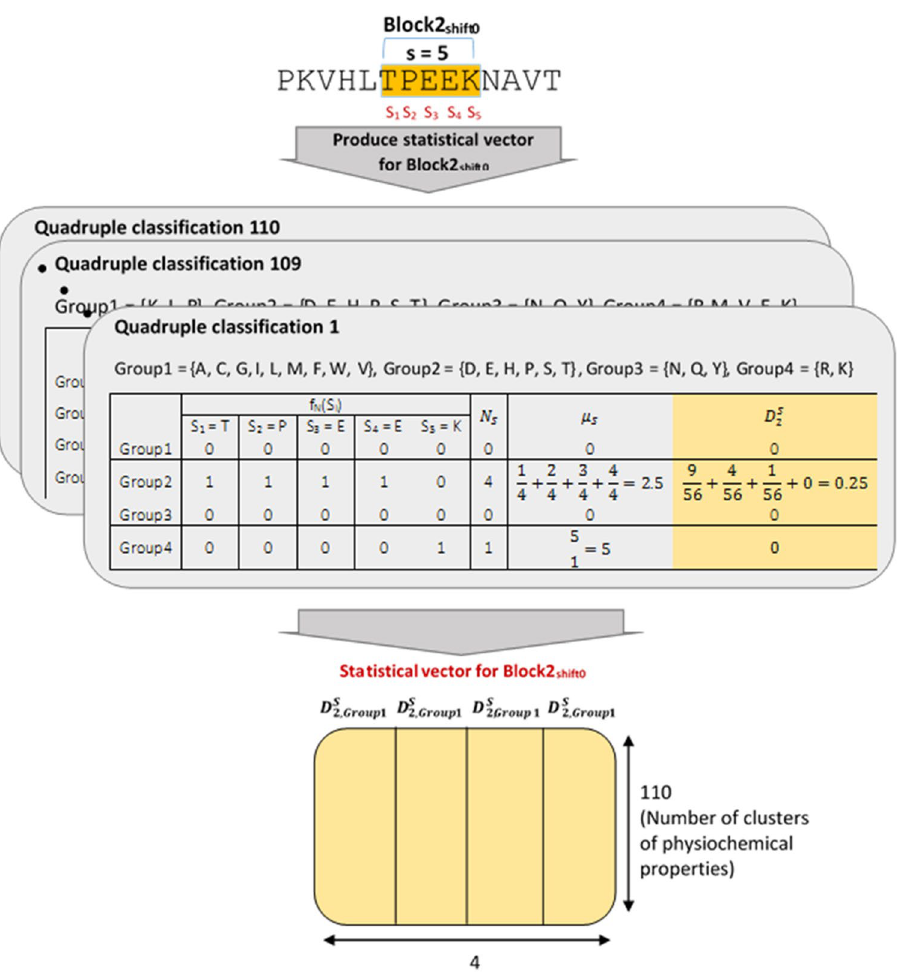
Figure 5. Producing statistical vector for each